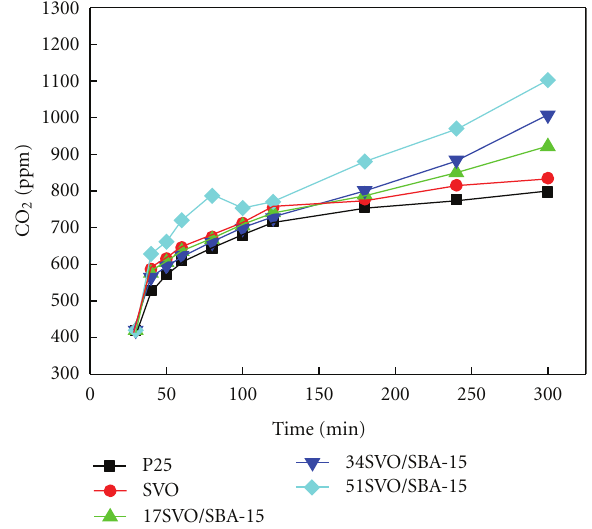
Figure 5: Concentrations of gaseous IPA during dark and visible- light irradiation.